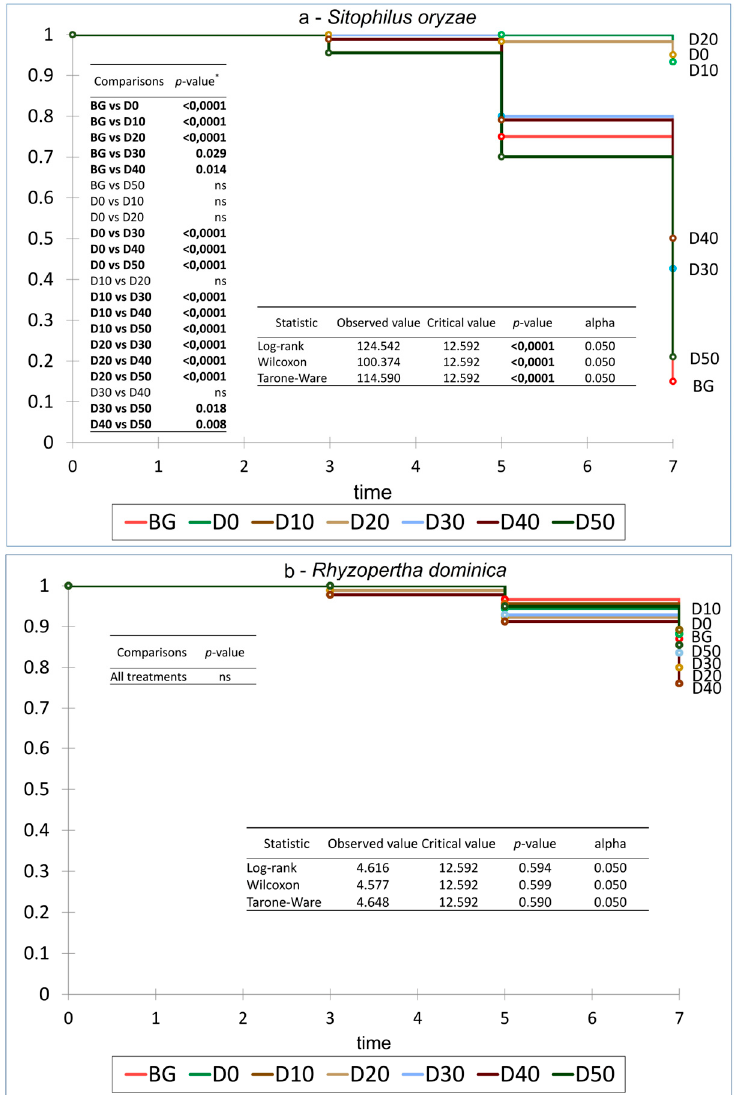
Figure 3. Kaplan–Meyer survival curve and p-value for a diet containing various doses of antibiotic and starving insects; BG: background (starving insects), D0: no antibiotic in the diet, D10 to D50: doses from 10 to 50 mg·g − 1 of the antibiotic in the feed.